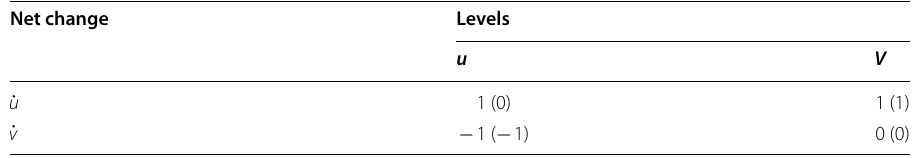
Table 4 The signs of partial derivatives at unstable E parentheses